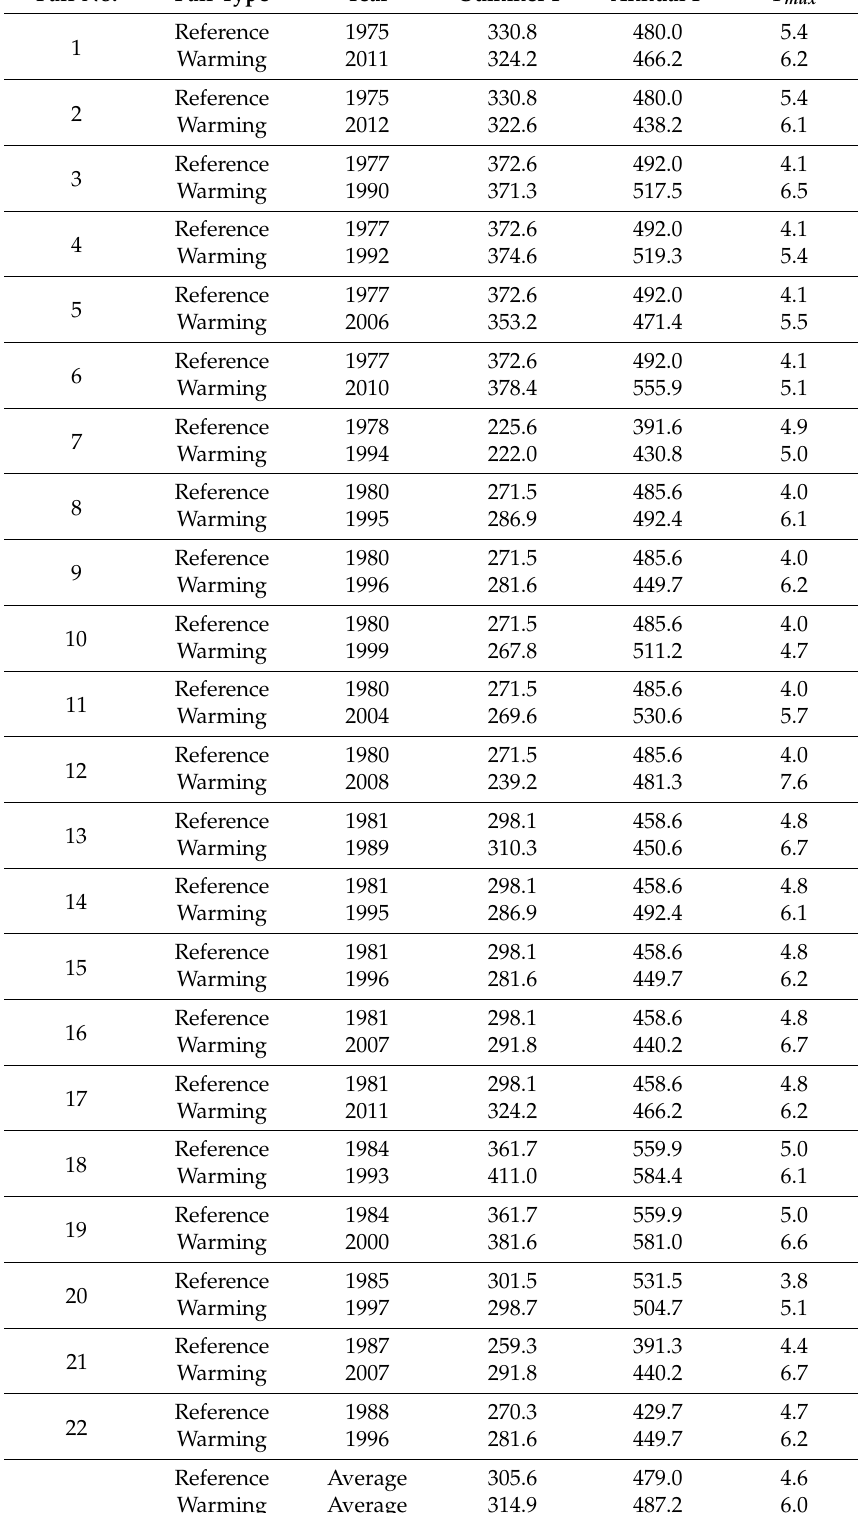
Table A3. Selected pairs for quantifying the effect of climate warming on high flow magnitude in the UHR